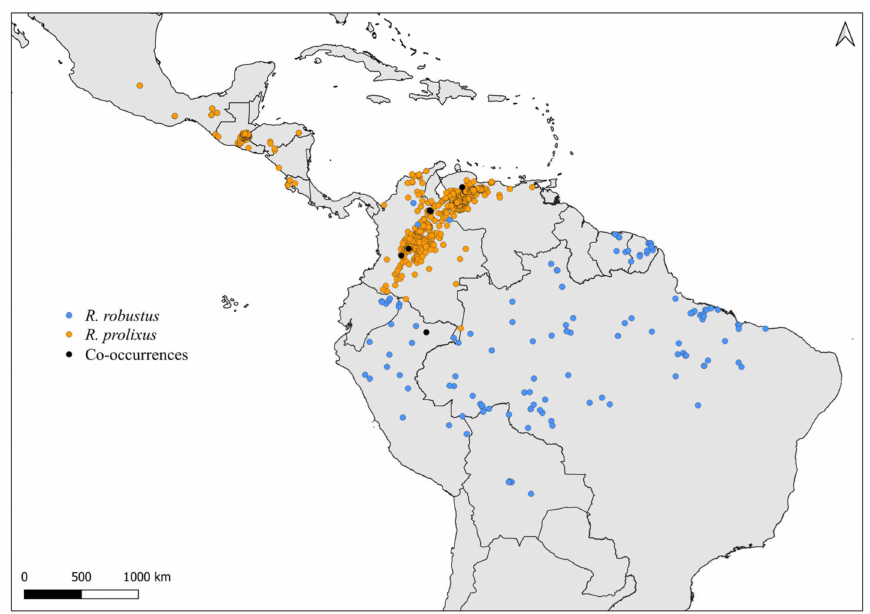
Figure 12. Distribution maps for R. prolixus and R. robustus